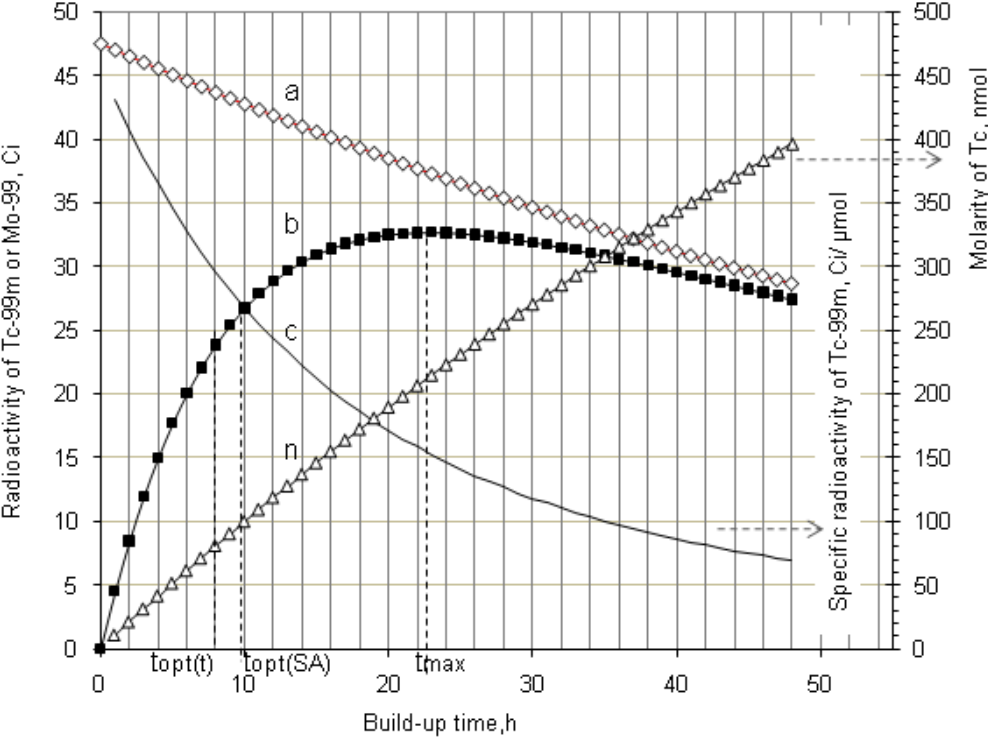
Figure 1. 99m Tc build-up in the 99 Mo/ 99m Tc generator system: 99 Mo activity (a); 99m Tc activity (b); Specific radioactivity of 99m Tc (c); Total atom numbers N or molarities of Tc